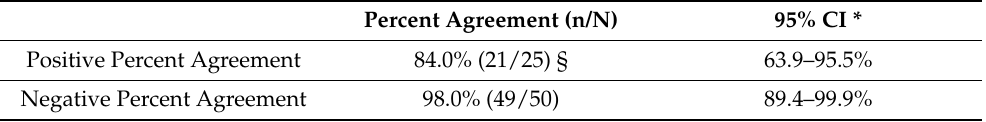
Table 3. Ebola Rapid Antigen Test agreement compared to the CDC Ebola Virus VP40 rRT-PCR